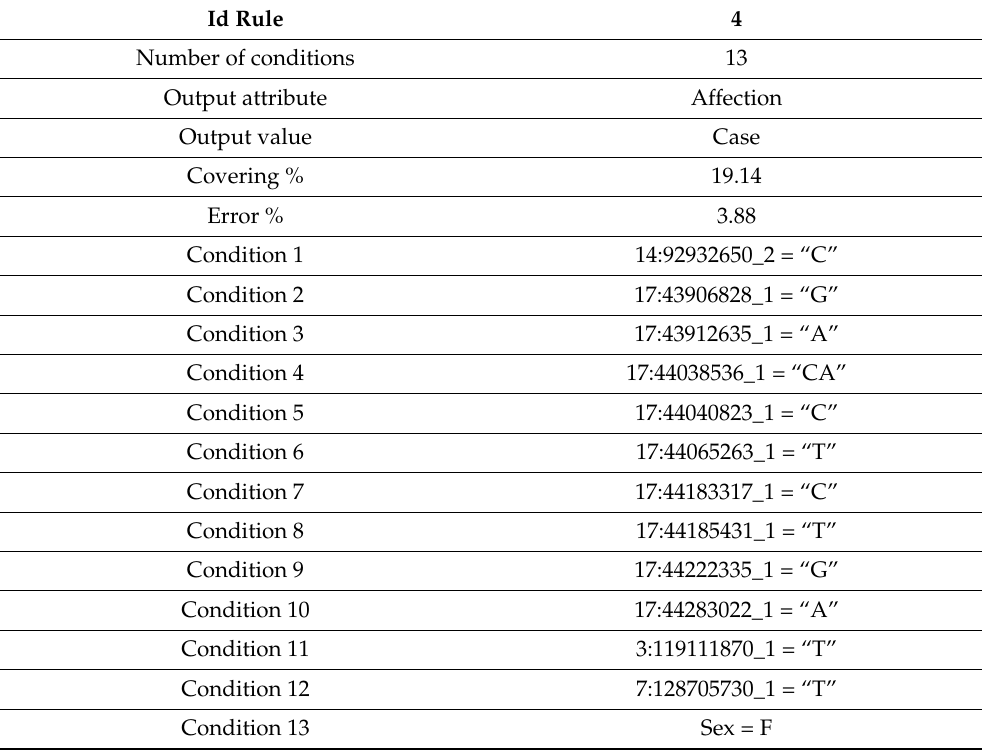
Table 2. Best rule for prediction including sex as condition.